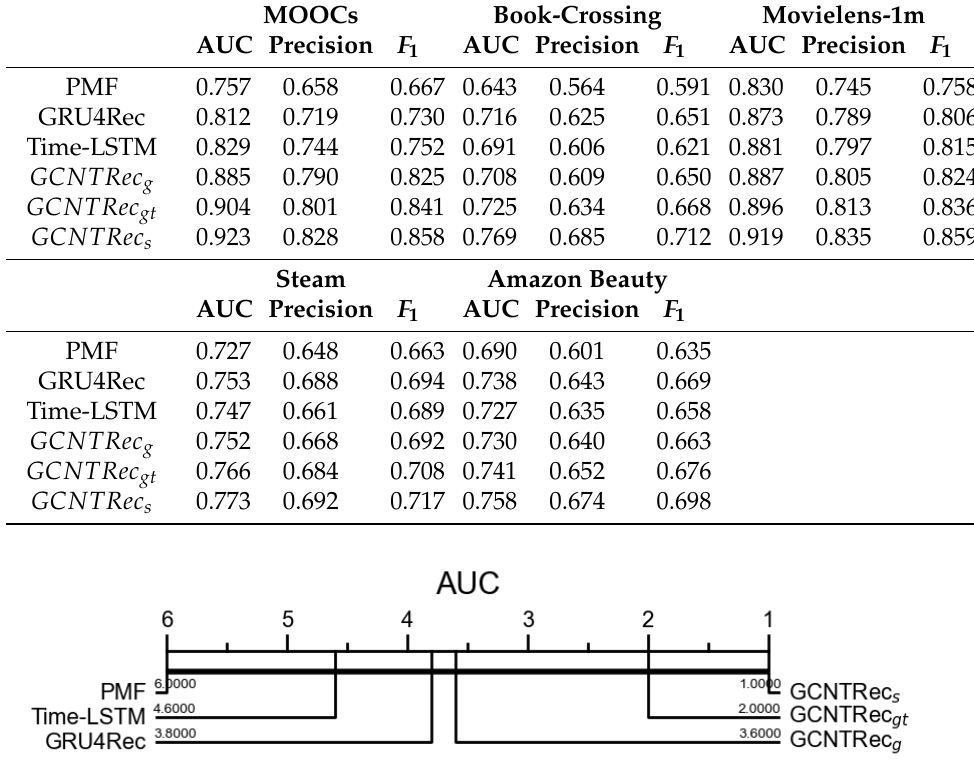
Figure 3. Critical difference diagrams for